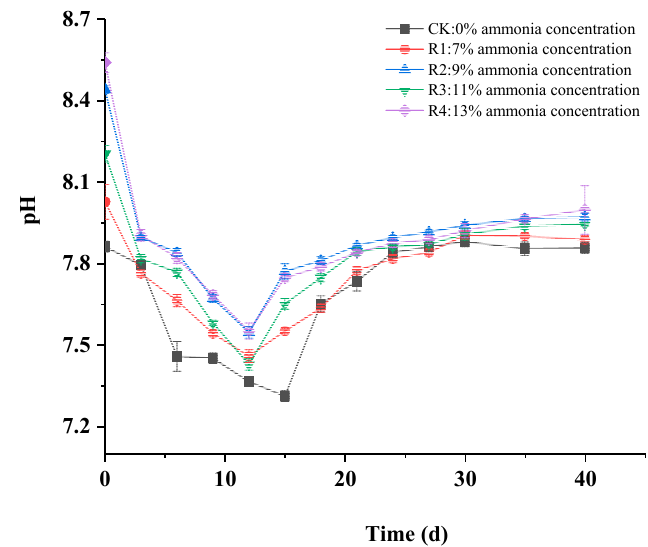
Figure 2. The VFA concentration of different pretreatment conditions.